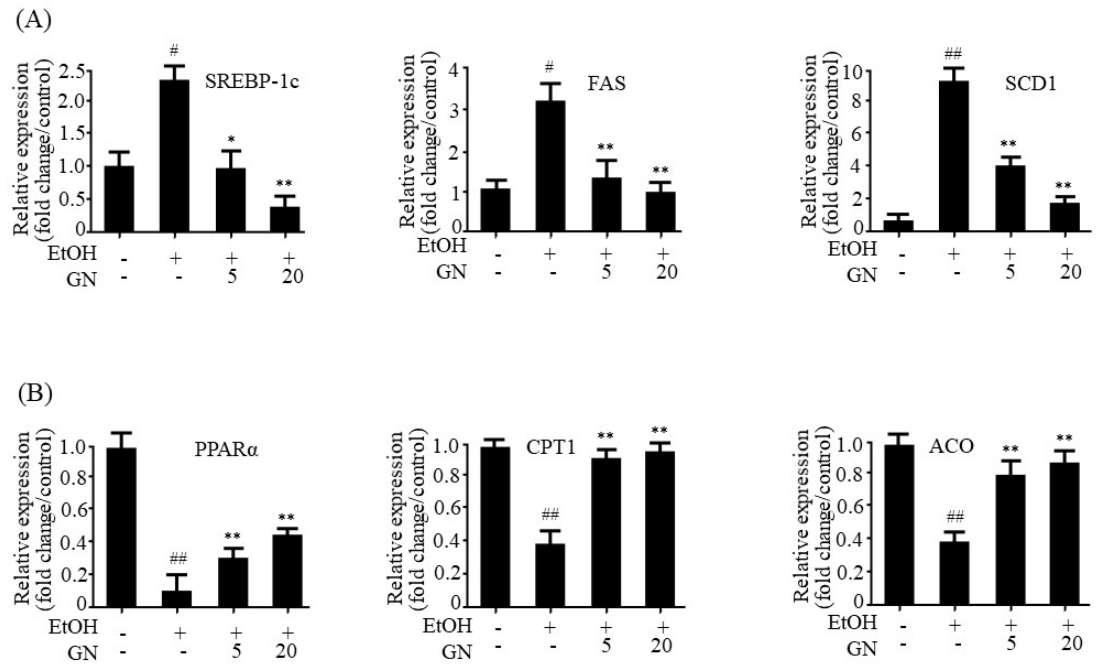
Figure 2. Gomisin N decreases the expression of lipogenesis and increases fatty acid oxidation genes in the liver of chronic-binge ethanol-fed mice. ( A ) qPCR analysis of sterol regulatory element-binding protein-1c (m SREBP-1c ), fatty acid synthase (m FAS ), and stearoyl CoA desaturase 1 (m SCD1 ). ( B ) qPCR analysis of peroxisome proliferator-activated receptor-α (m PPARα ), carnitine palmitoyltransferase 1 (m CPT1 ), and acyl-coenzyme A oxidase (m ACO ). Values are the mean ± SD ( n = 6). # p < 0.05, ## p < 0.01 vs. pair-fed control mice, * p < 0.05, ** p < 0.01 vs. ethanol-fed mice.